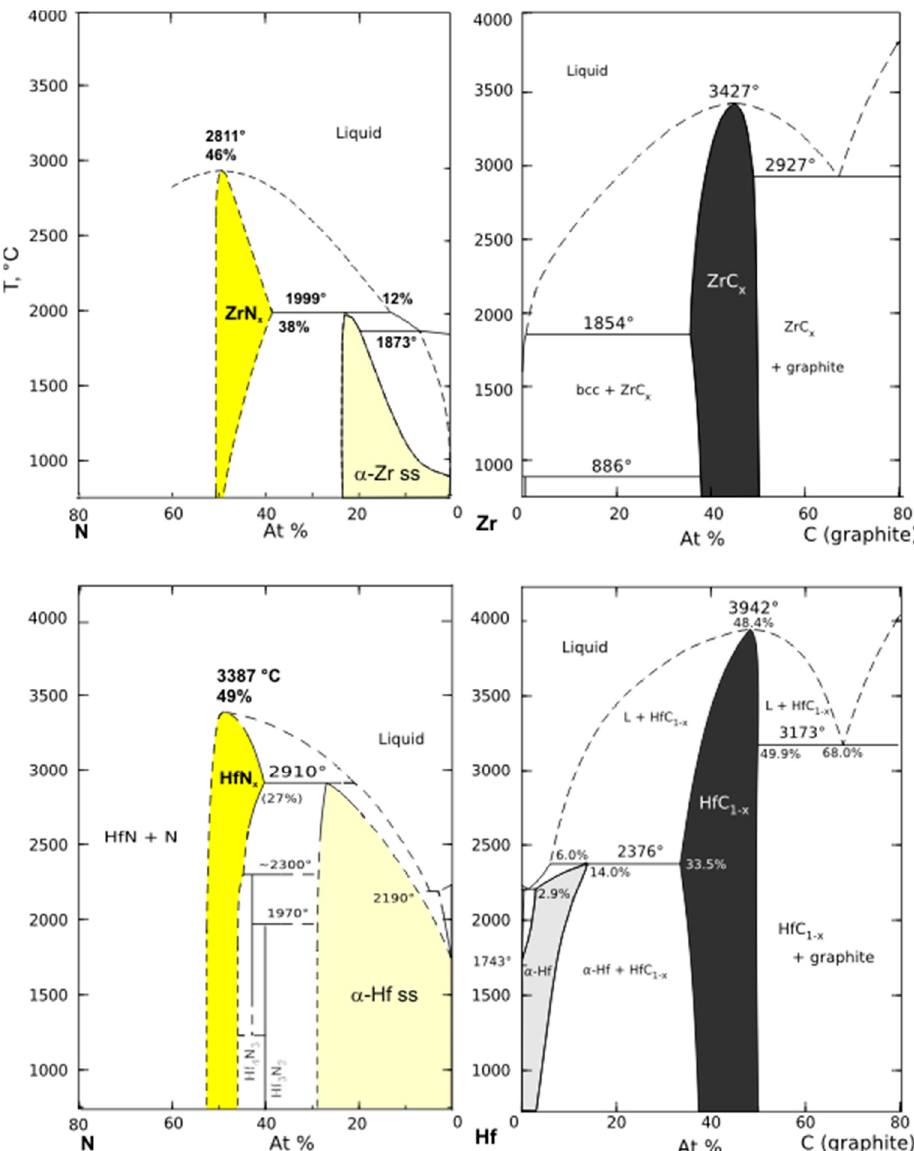
Figure 2. Binary phase diagrams for condensed system of Zr and Hf with graphite and nitrogen (at 1 atm pressure), redrawn after: (Zr-N)—Ma et al. (2004) [57]; (Zr-C)—Gullerment (1995) [58]; (Hf-N)—Okamoto (1990) [59]; (Hf-C)—Bittermann and Rogl (1997) [60].